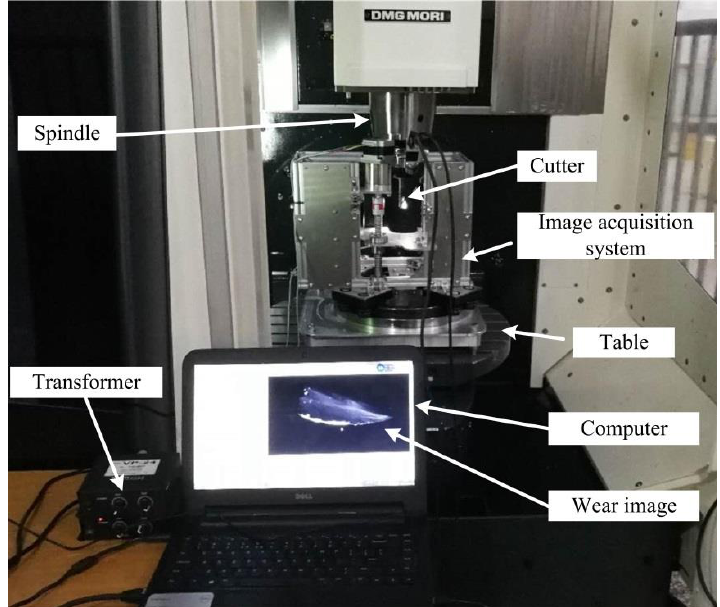
Figure 9. Experiment setup for machining process and tool inspection.